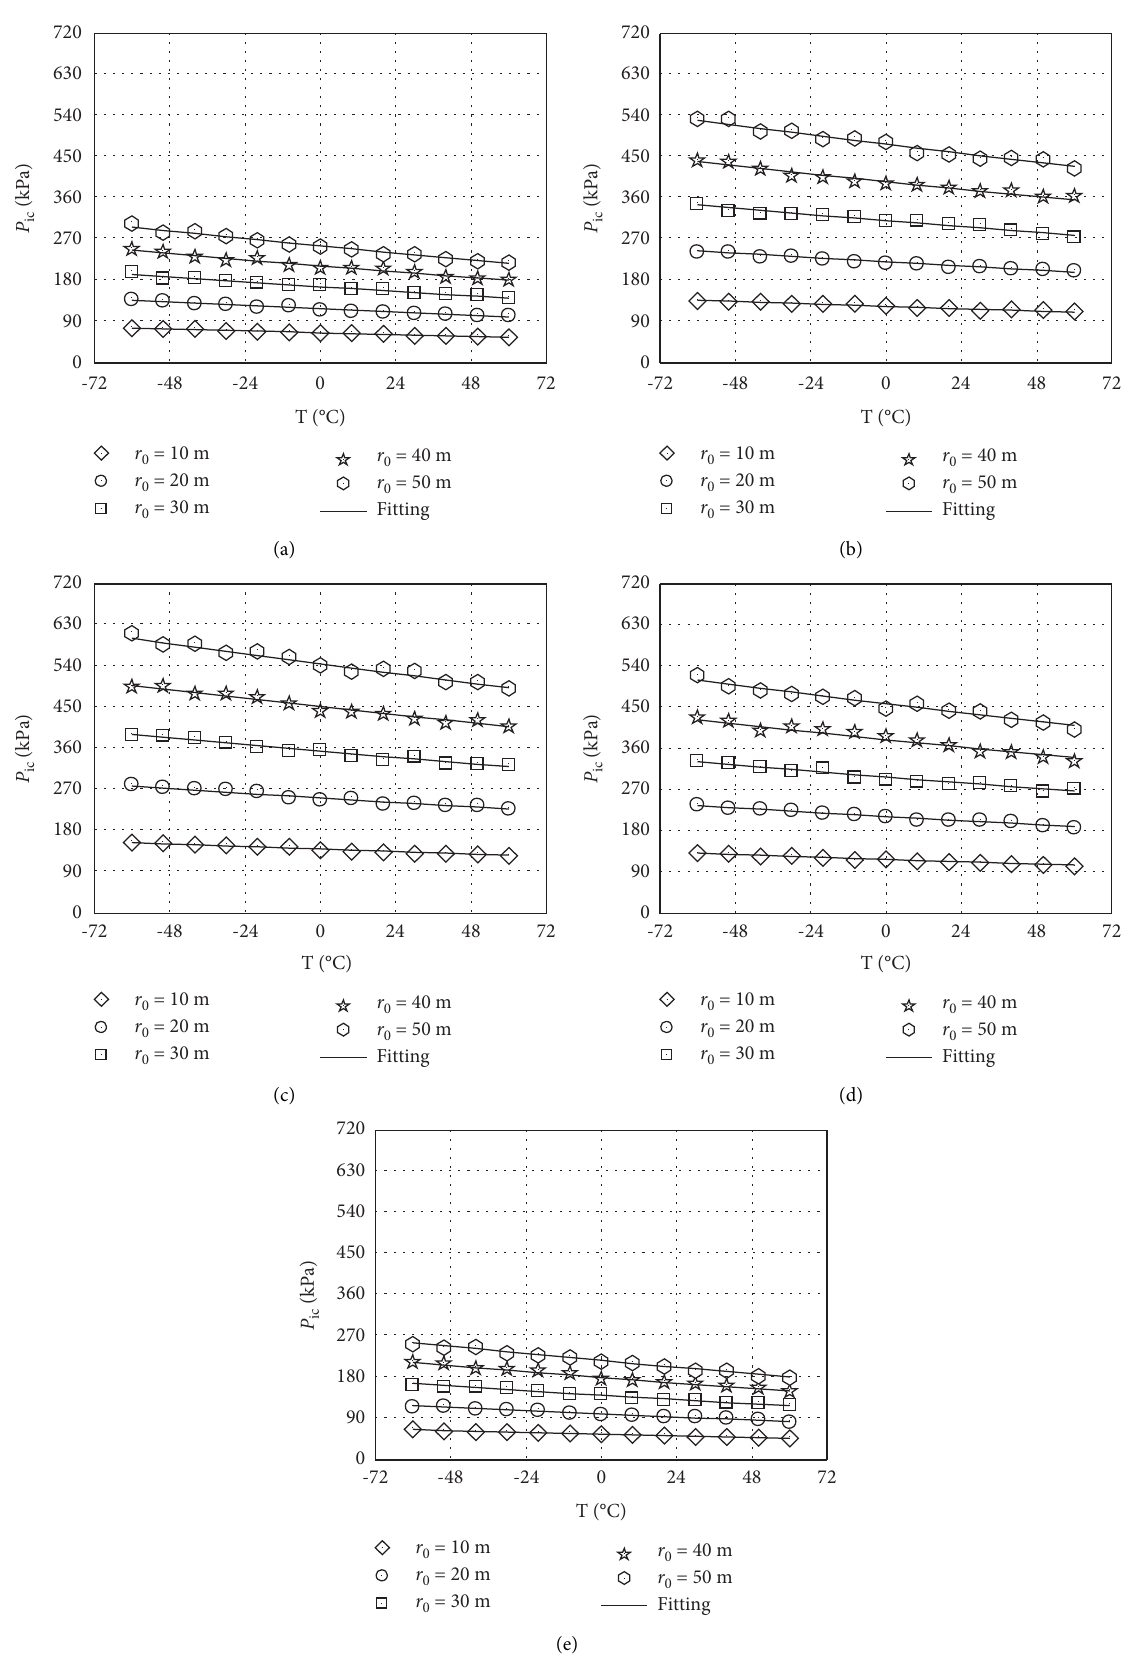
Figure 6: Relation between p ic and T under different initial gas volume concentration environment conditions. (a) C (c) C � 10%. (d) C � 12%. (e) C �